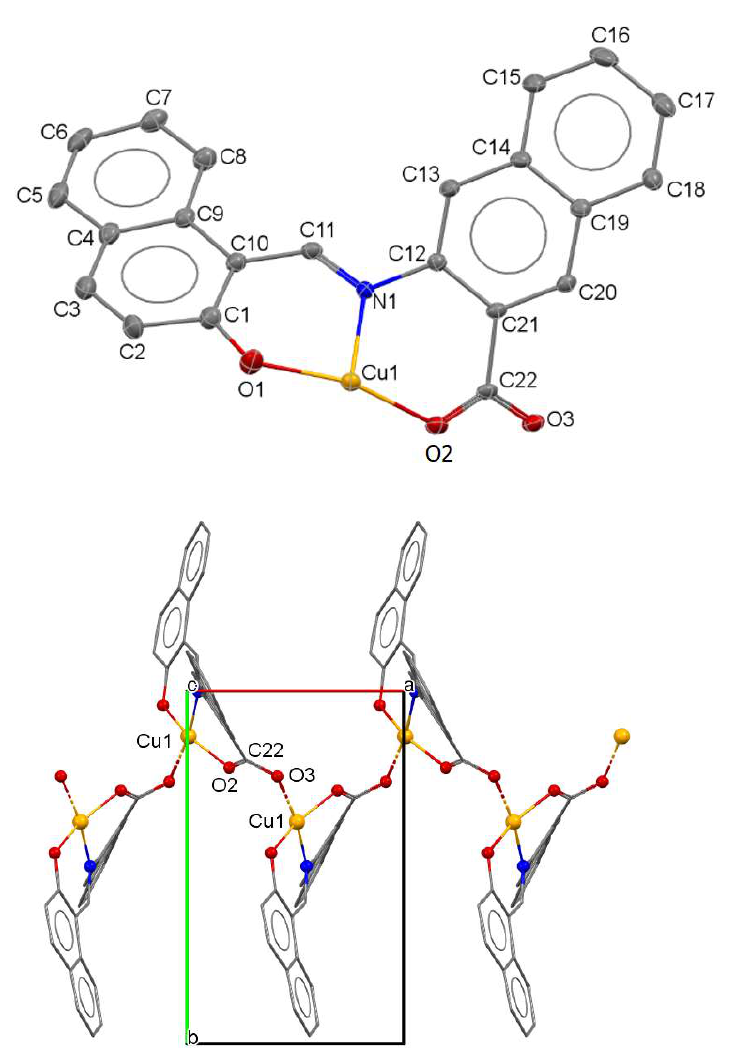
Figure 1. ( top ) ORTEP plot of the asymmetric unit of [Cu II ( nanc )] n ( 1 ) with the appropriate atomic labelling scheme. Thermal ellipsoids are plotted at 50% and H atoms are omitted for clarity; ( bottom ) crystal packing of 1 , view down the crystallographic c -axis showing the 1-D chain topology; H atoms are omitted for clarity.